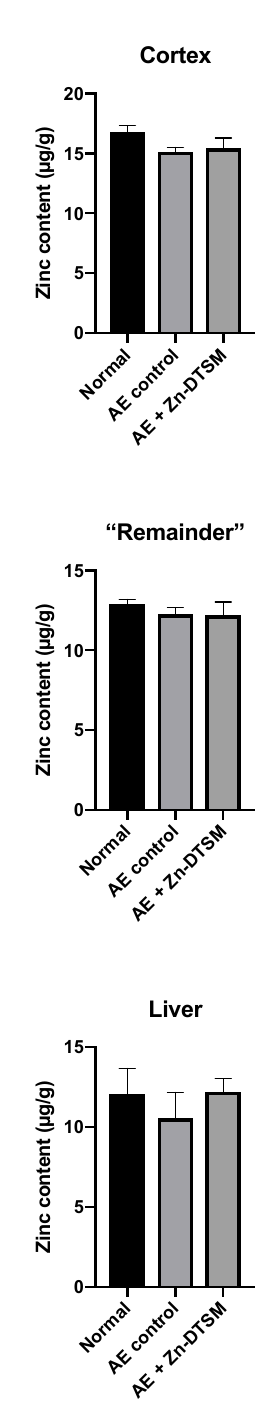
Figure 7. Zinc levels in various tissues harvested from 5-month-old acrodermatitis enteropathica (AE) mice treated with zinc diethyl bis(N4-methylthiosemicarbazone) (Zn-DTSM; 30 mg/kg/day). There are no significant effects of the drug on metal levels in any of the tissues examined. Data are mean ± SEM.